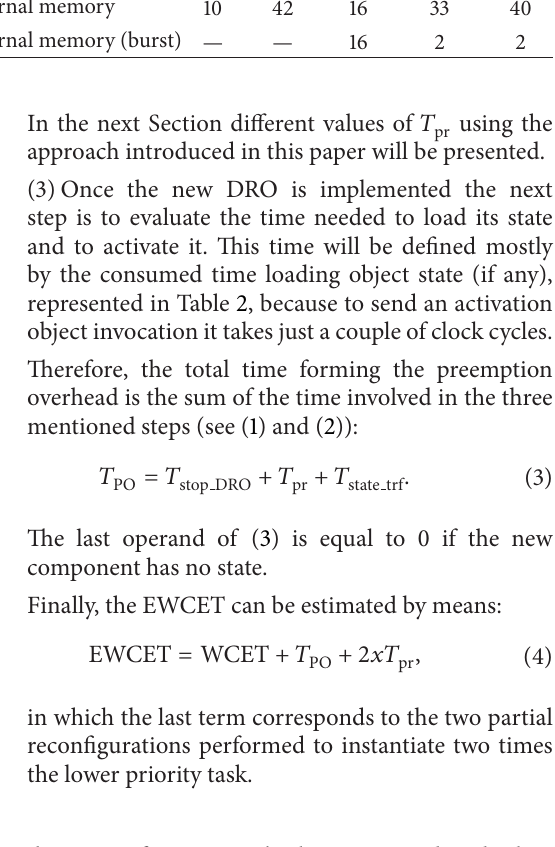
) measured in state trf